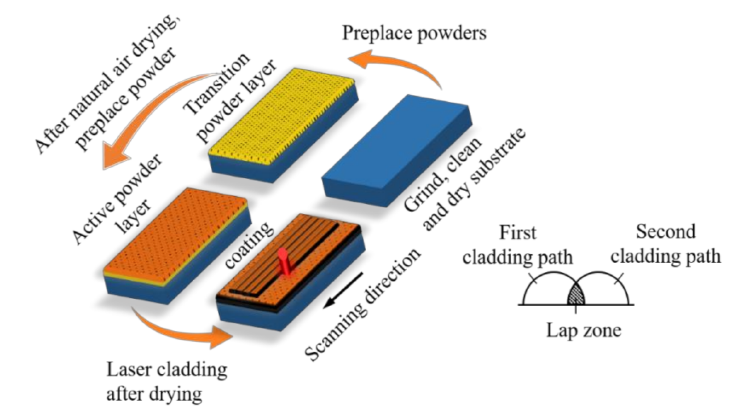
Figure 2. Flow diagram of the laser cladding